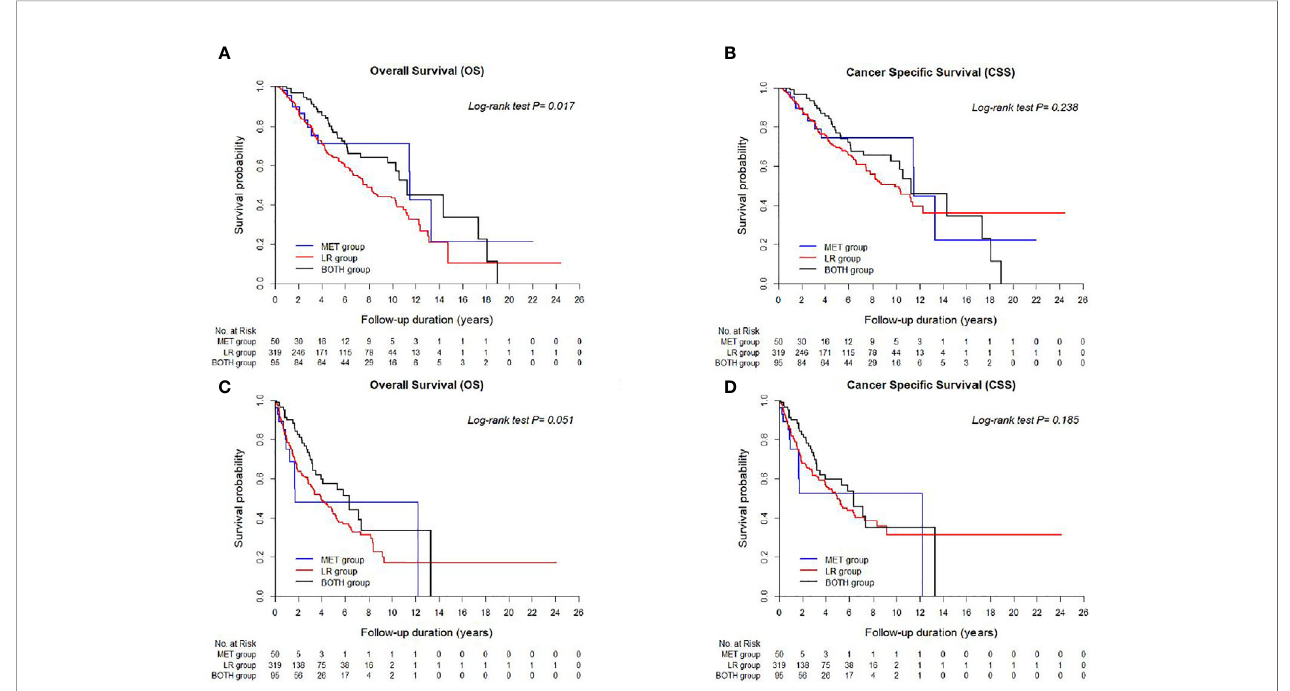
FIGURE 2 | Kaplan-Meier curves between LR, BOTH, and MET groups for (A) Overall survival (OS) and (B) Cancer-speci fi c survival (CSS) from the date of nephrectomy, and (C) OS and (D) CSS from the date of disease recurrence or